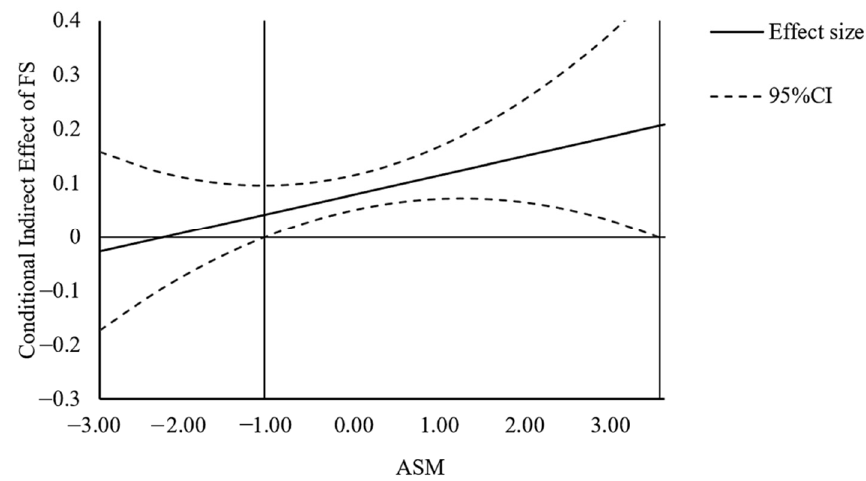
Figure 3. The indirect effect of Income on Life Satisfaction (LS) via Financial Satisfaction (FS) versus Ability to Savor the Moment (ASM), with confidence bands in study 2.